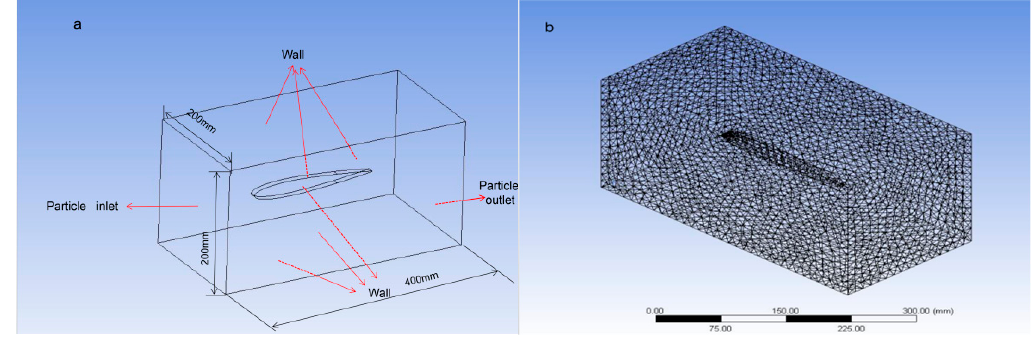
Figure 1. Geometric details of the helicopter rotor blade.